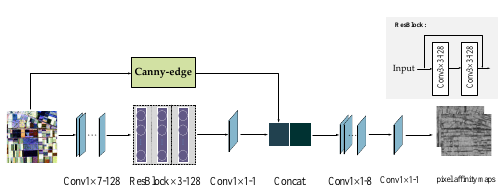
Figure 3. The framework of the PAN. The PAN is utilized to predict horizontal and vertical affinities at every pixel. The gray area in the upper right corner shows the standard structure of a ResBlock